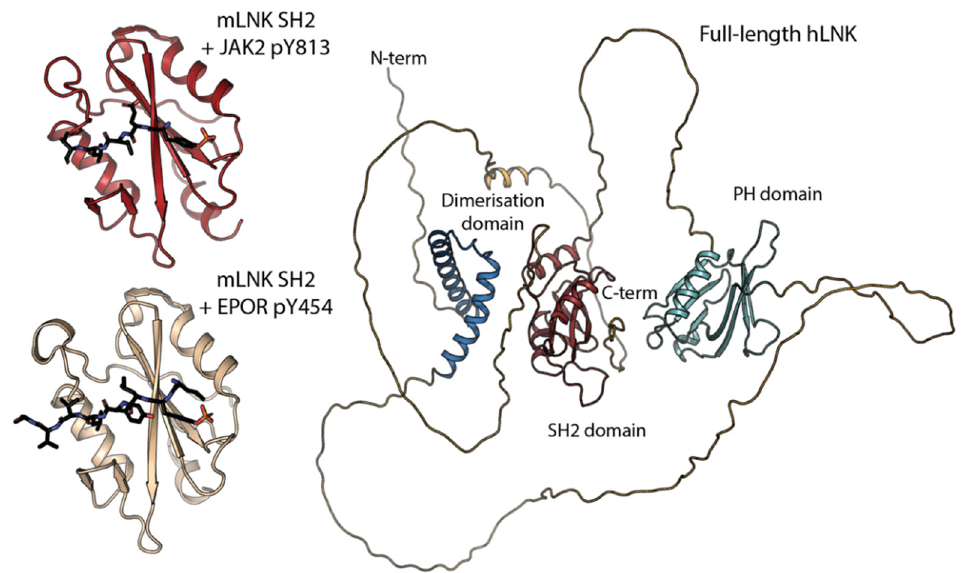
Figure 2. Structure of LNK (SH2B3). The domain architecture of full-length LNK ( right , prediction from AlphaFold) includes three functional domains. The first is a dimerisation domain, a central pleckstrin homology domain and a C-terminal SH2 domain joined by what is predicted to be unstructured regions ( left ). The crystal structures of the M. musculus LNK SH2 domain with JAK2 pY813 (PDB ID: 7R8W) and EPOR pY454 (PDB ID: 7R8X) peptides.